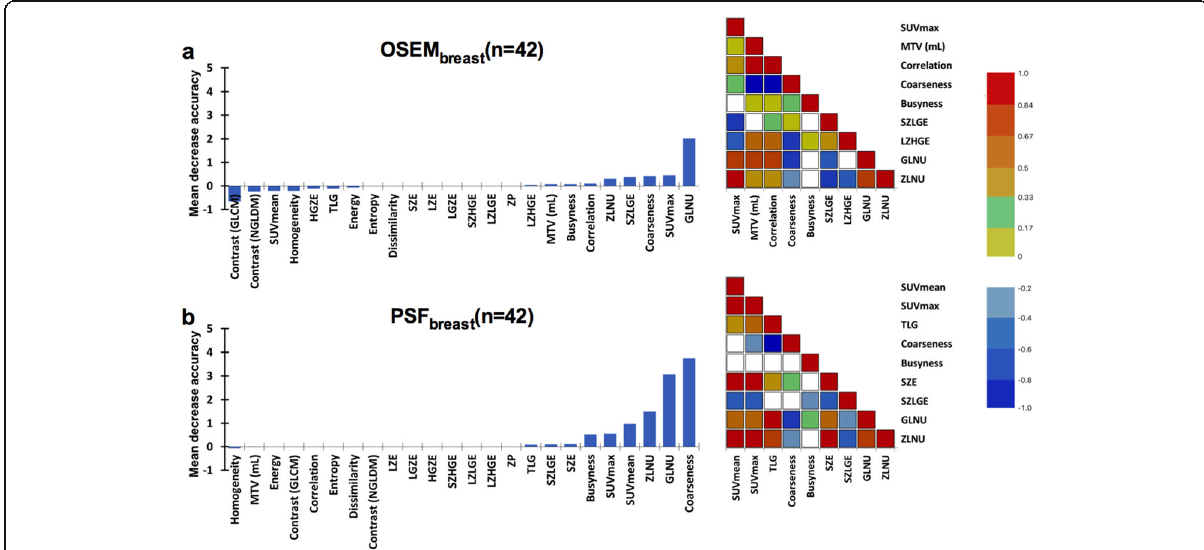
Fig. 3 Left panels display the mean decrease accuracy of textural features values and right panels display Spearman correlation matrixes of all PET metrics found to have positive mean decrease accuracy, whatever the value for OSEM breast ( a ) and PSF breast ( b ) reconstructions. For Spearman correlation matrixes, the blue colour corresponds to a correlation close to − 1 and the red colour corresponds to a correlation close to 1. The green corresponds to a correlation close to